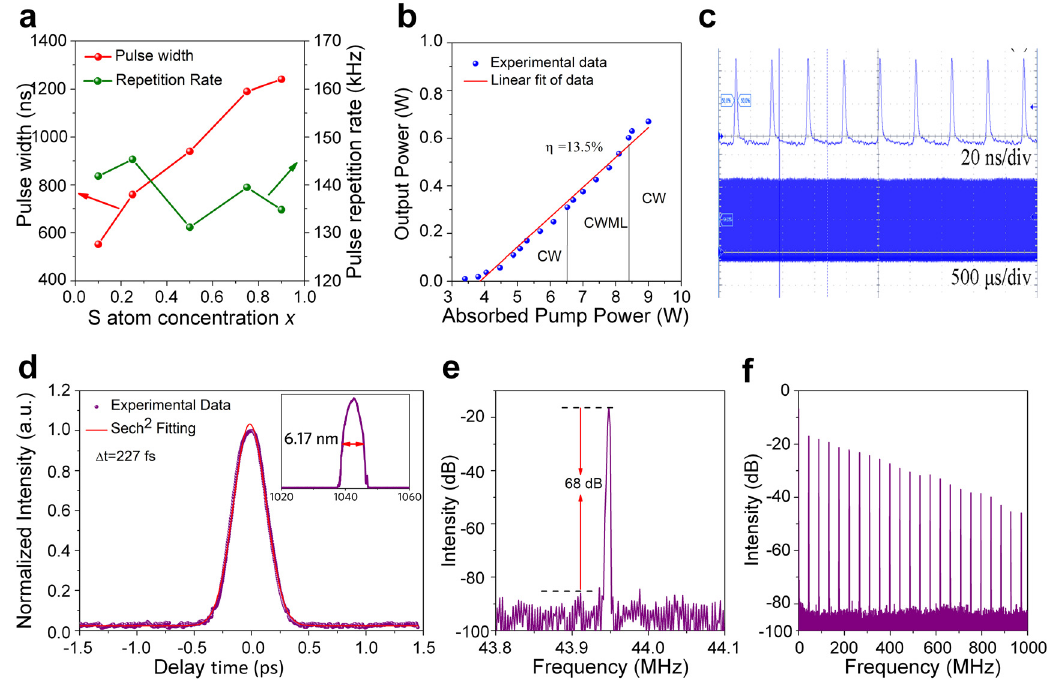
Figure 6: The CWML performance based on MoS 0.2 Se 1.8 SA. (a) Pulse width and repetition rate versus the composition x based Q-switched laser. (b) Average output power versus the absorbed pump of the MoS 0.2 Se 1.8 -based CWML laser. (c) Recorded typical pulse trains of CWML at the maximum output power. (d) Autocorrelation trace for 227 fs of CWML laser; inset is emission spectrum. Recorded frequency spectrum with a narrow (e) and a wide span